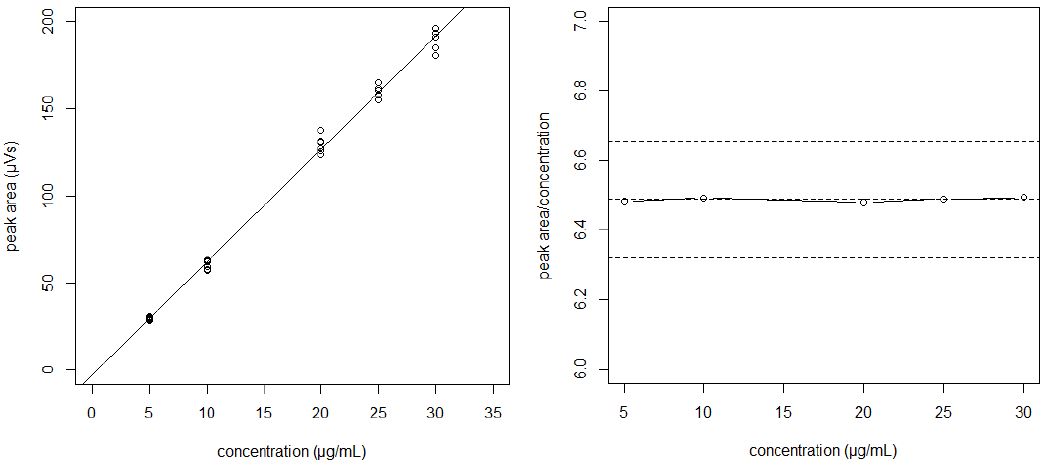
Figure 1. The regression line “peak area vs. concentration” obtained by pooling data from different days ( left ). The plot of the peak area / concentration ratio vs. concentration shows the variability of the slopes between points (right).